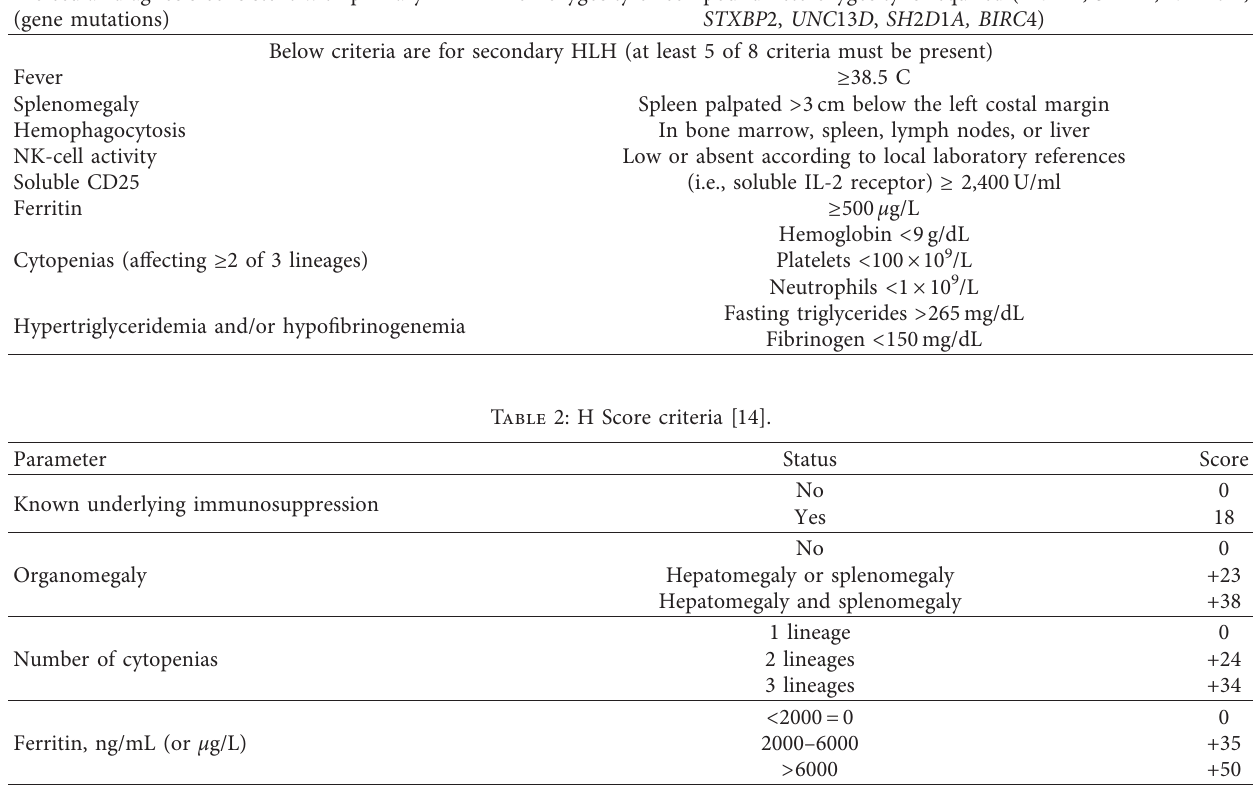
Table 1: HLH 2004 criteria [14].